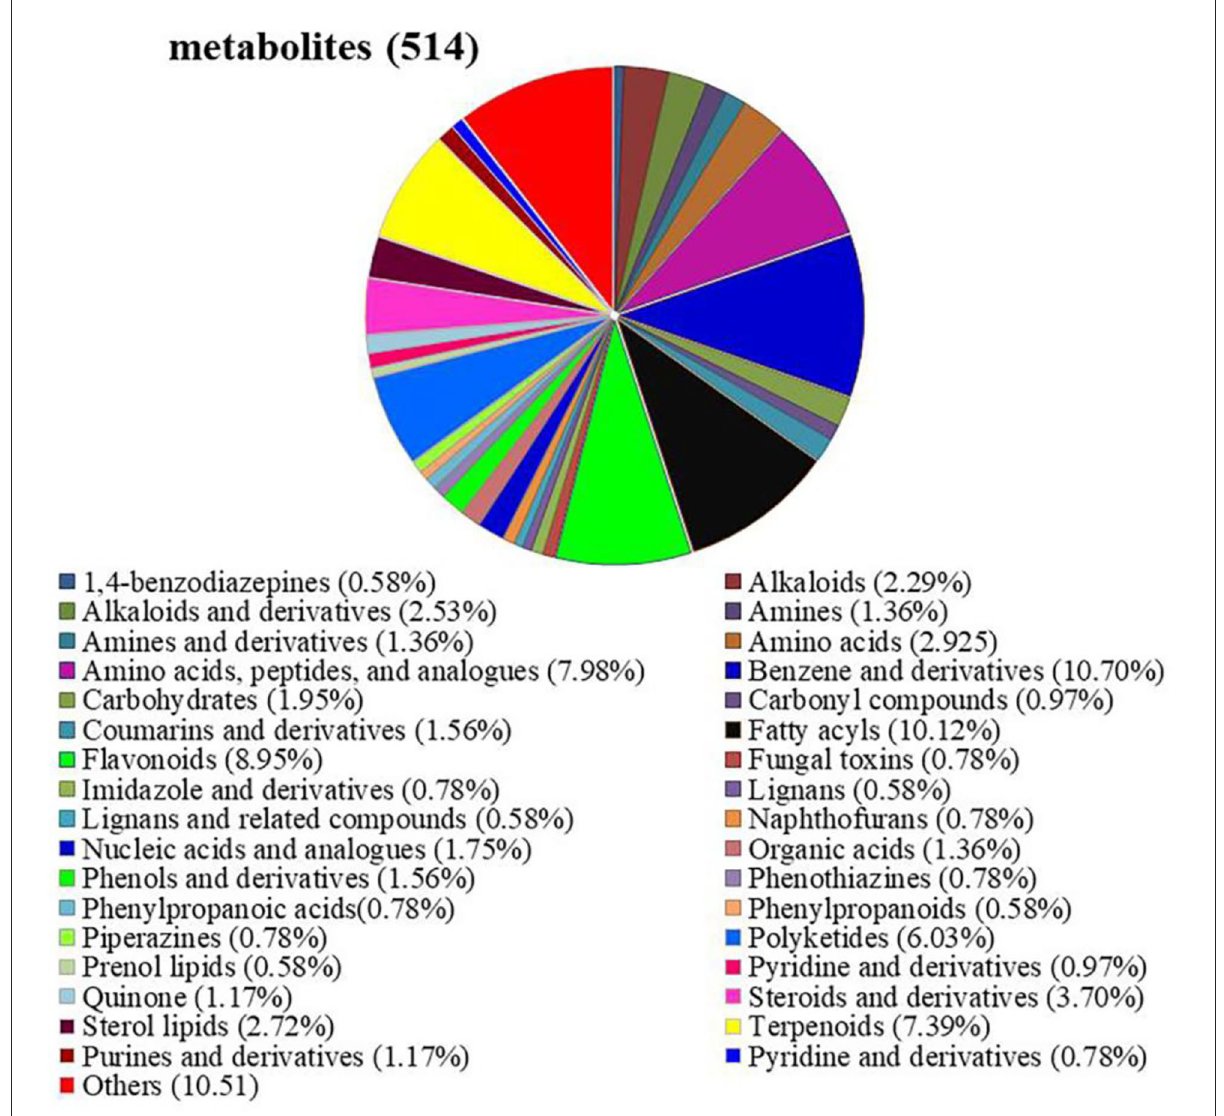
FIGURE4 Detection of metabolites between E + barley and E– barley under salt stress conditions. Pie chart showing the metabolite classification of barley inoculated with E. bromicola and subjected to NaCl concentrations of 0, 100, and 300mM. The classification information in this figure is derived from HMDB and KEGG databases. Analysis and detection of metabolites according to